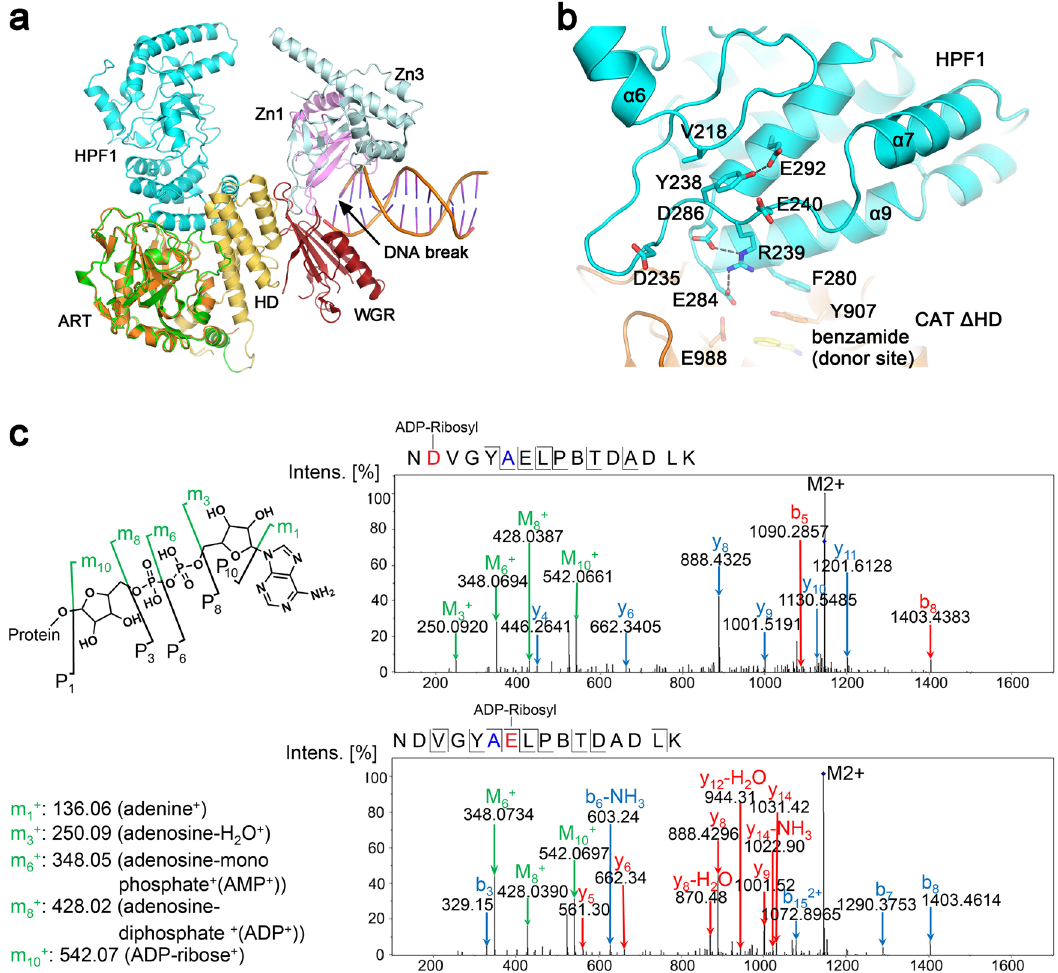
Fig. 4 Depicting the function of HPF1 Arg239. a Comparison of the HPF1/PAPR1-CAT Δ HD complex structure and the DNA-bound PARP1 crystal structure (PDB 4DQY) 18 by superimposing the ART domains from both (orange — ART determined in this report; green — ART of PDB 4DQY). HPF1 binding to PARP1 would presumably dislodge PARP1 automodi fi cation domain (AD) that was previously proposed to be located roughly in the same position where HPF1 binds (see Supplementary Fig. 1), thus prevents automodi fi cation of PARP1. b A close view of the long α 6- α 7 loop region structure and its position relative to the active center of the HPF1/PARP1 complex. c Mass Spectrometry analysis revealed that HPF1 R239A mutation resulted in ADP-ribosylation on Asp235 and Glu240, a unique phenomenon only seen in this mutant (see Fig. 2B, black arrow). The mutated residue 239 is shown in blue in the sequence, while the modi fi ed residues Asp235 and Glu240 are shown in